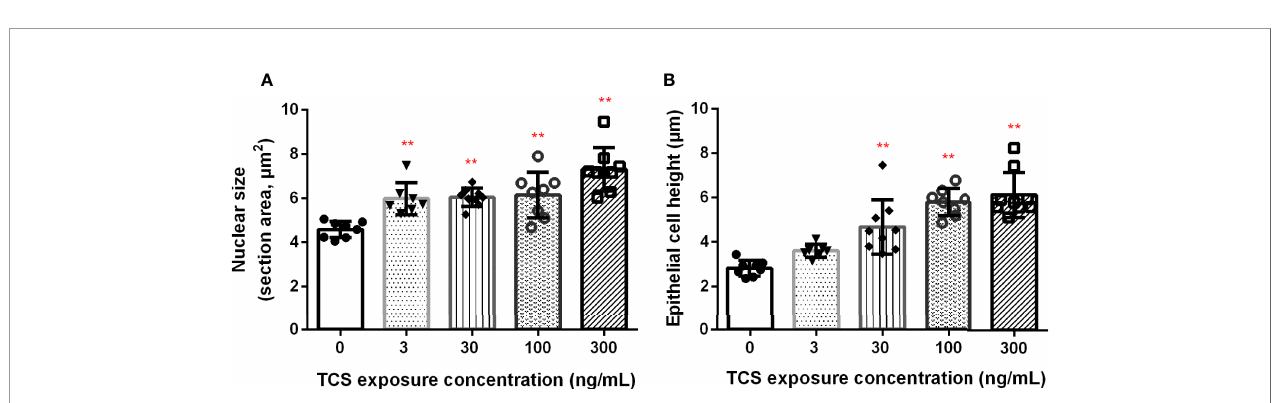
FIGURE 2 | The association between TCS exposure concentrations and nuclear area (A) and the height (B) of thyroid follicle cells. P trend < 0.0001 both for nuclear size and epithelial height of the thyroid. ** P < 0.01 in the TCS exposure group vs. the control